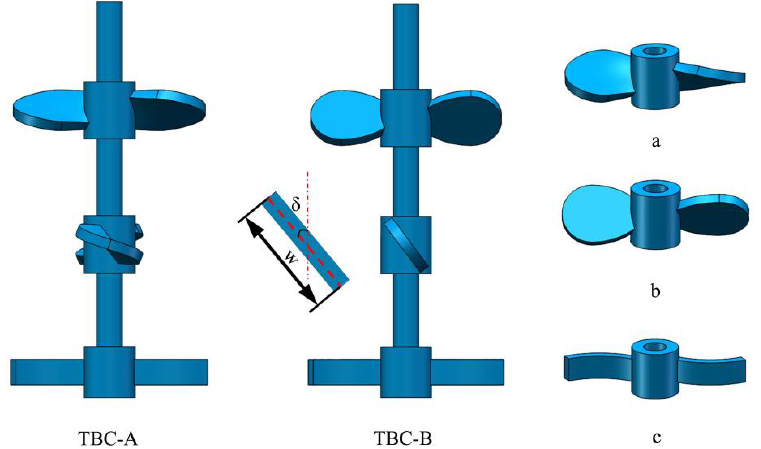
Figure 2. Structural characteristics of two three-blade combined agitators, contain angle between section and mixing axis δ , Sectional leaf width w. Table 1. Parameters of two kinds of propeller blade structures.